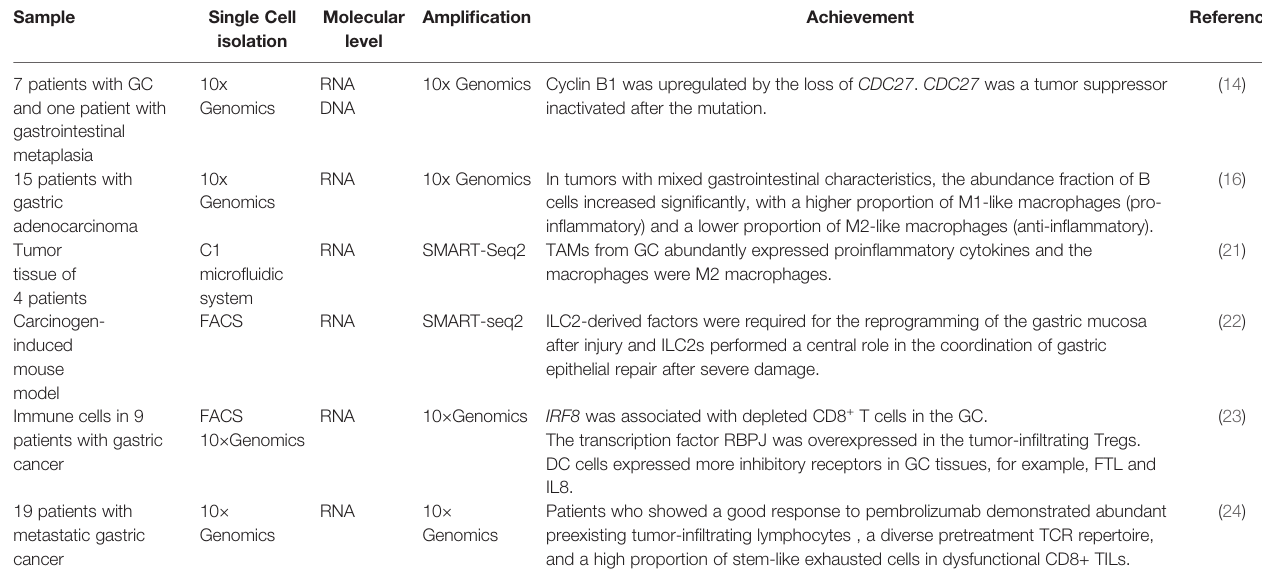
TABLE 2 | SCS in microenvironment of gastric